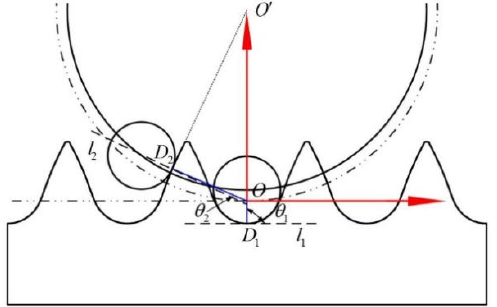
Figure 22. Schematic diagram of double tooth meshing of the trochoidal roller pinion rack.